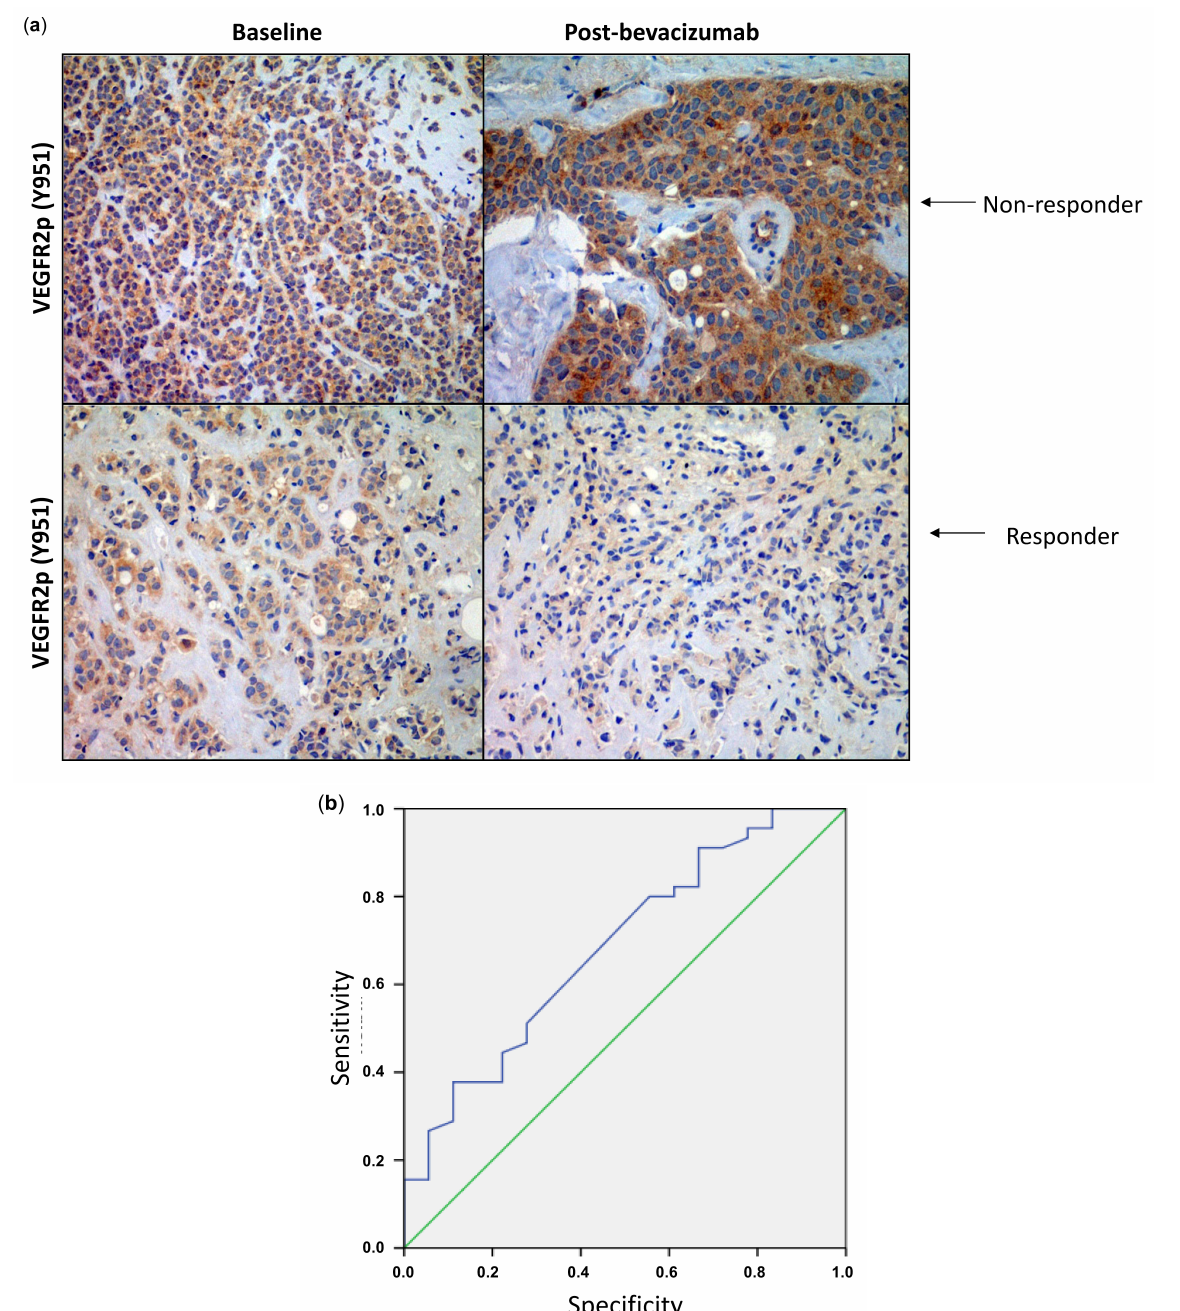
Figure 2. ( a ) Examples of representative immunohistochemistry staining of vascular endothelial growth factor receptor-2 (VEGFR-2) at baseline and post-bevacizumab for responders and nonresponders; ( b ) VEGFR-2 changes after bevacizumab treatment by immunohistochemistry staining and association with response as shown by receiver operator characteristic curve (AUC = 0.68, 95% CI 0.54, 0.82; p = 0.02). AUC, area under the curve; CI, confidence